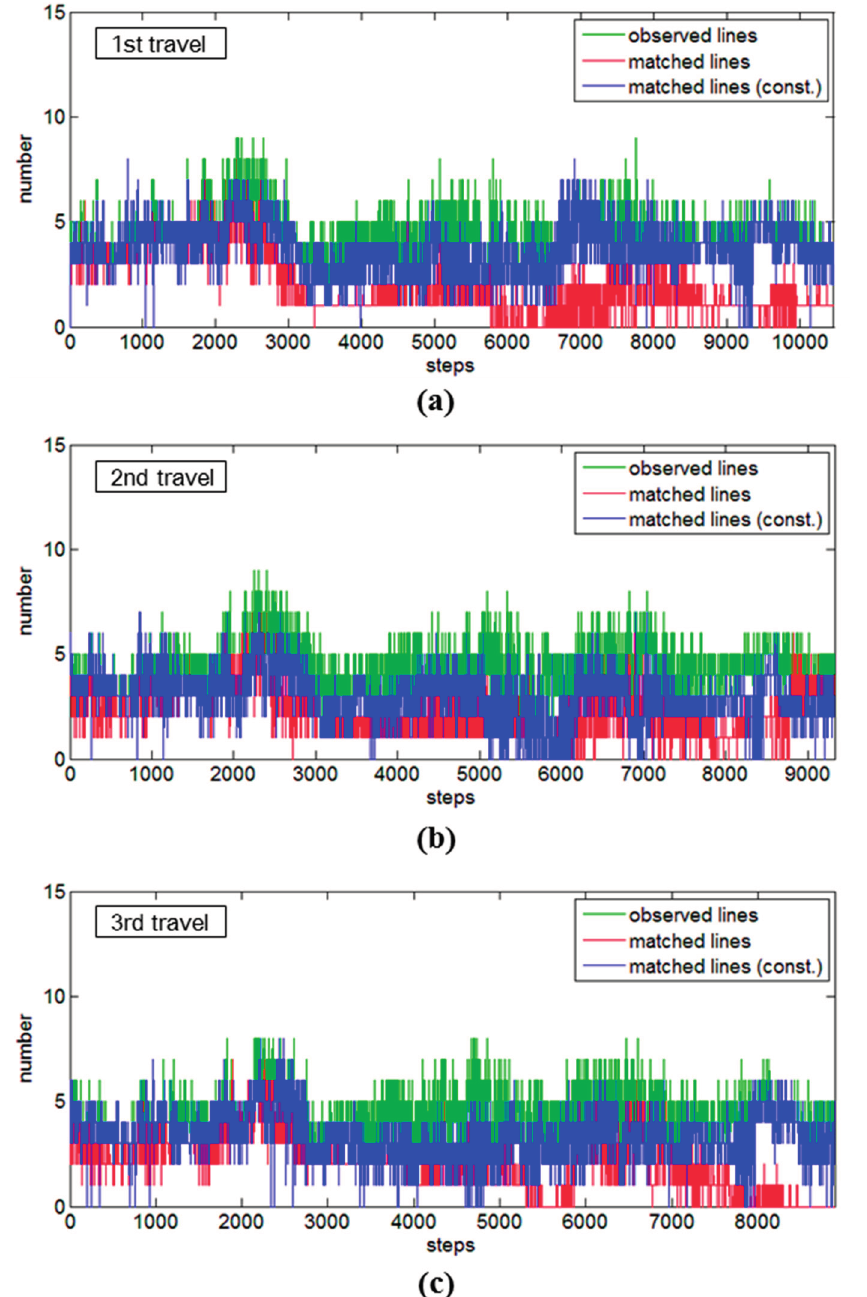
Figure 10. Comparisons of data association results for the seminar room test: ( a ) first travel; ( b ) second travel; and ( c ) third